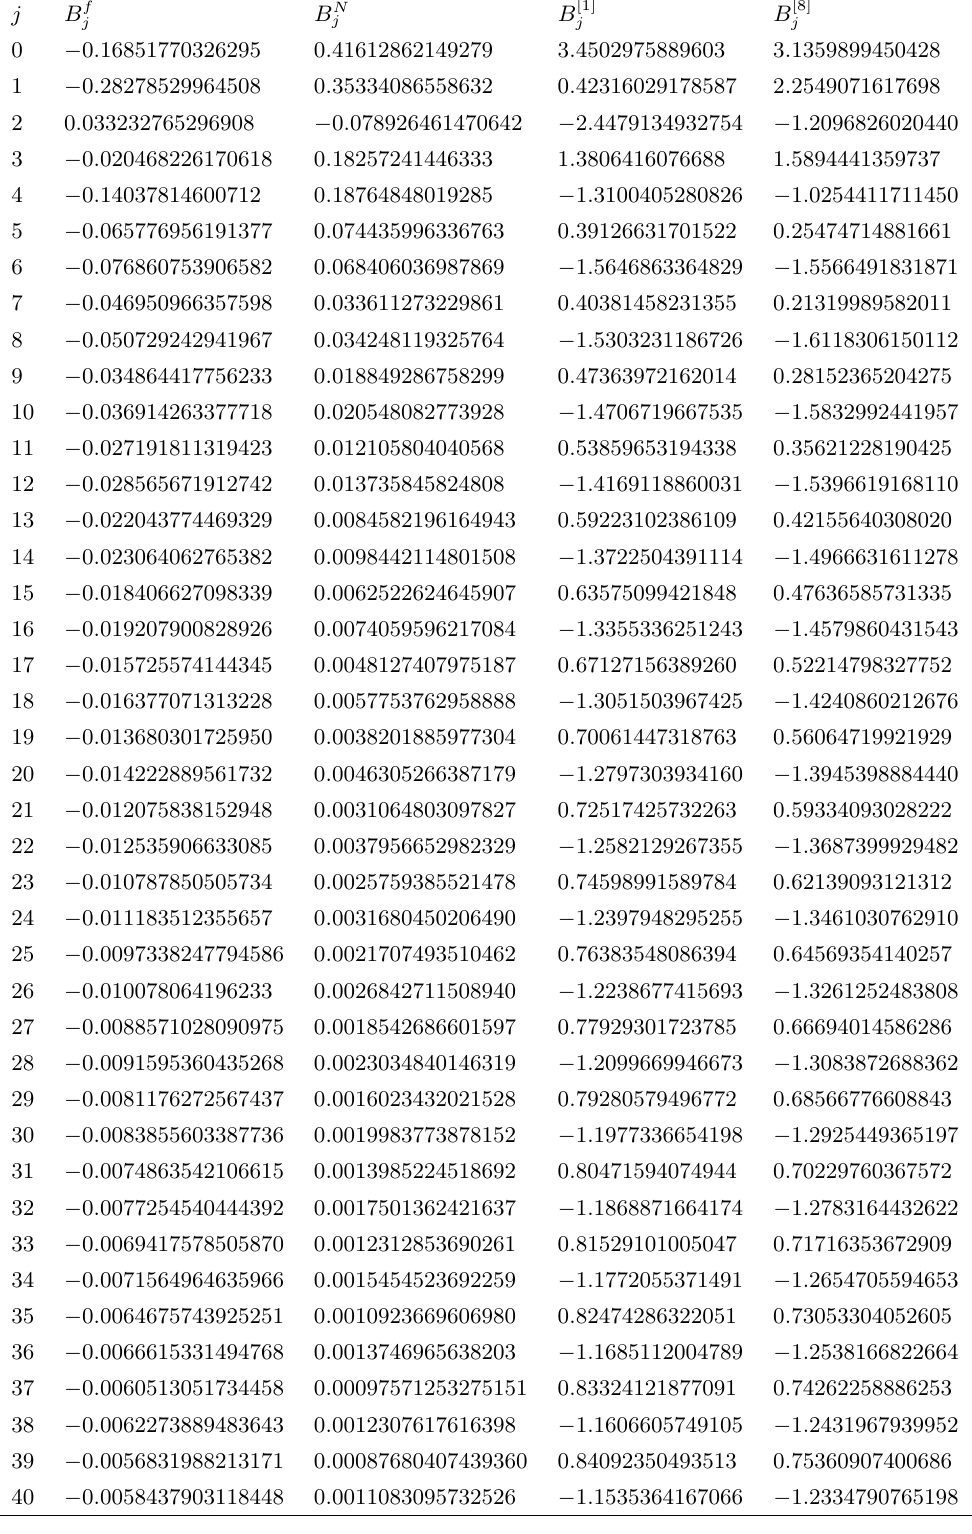
Table 6 . Coe(cid:14)cients of the asymptotic expansion at z = 1 =